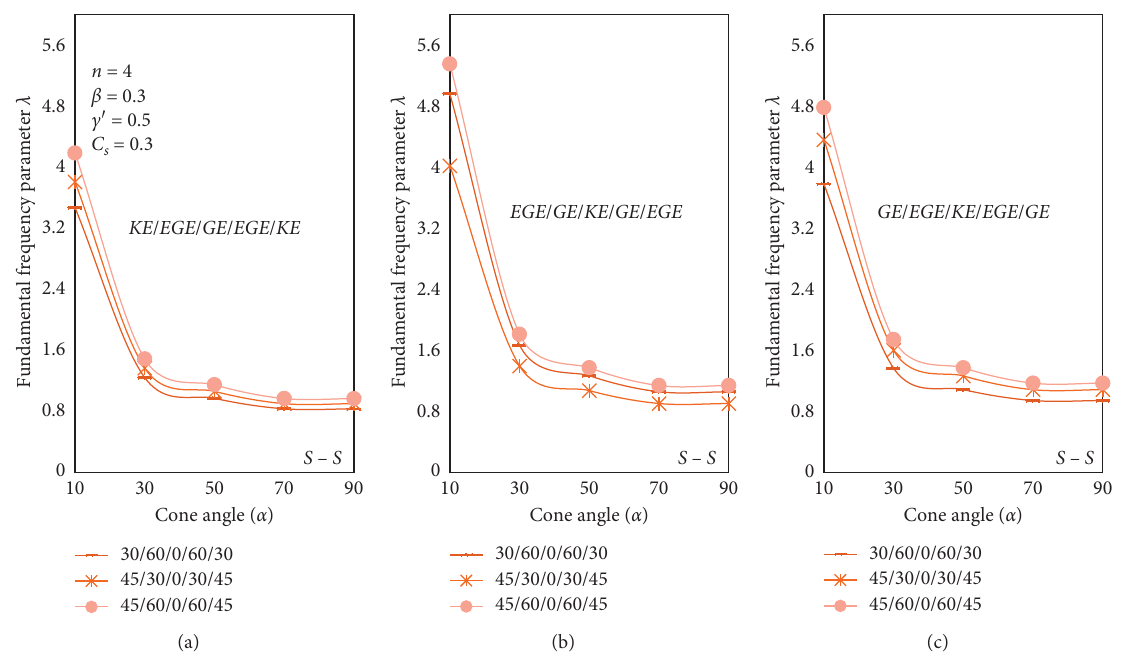
Figure 7: Influence of cone angle on the fundamental frequency parameter of five-layered conical shells with different material